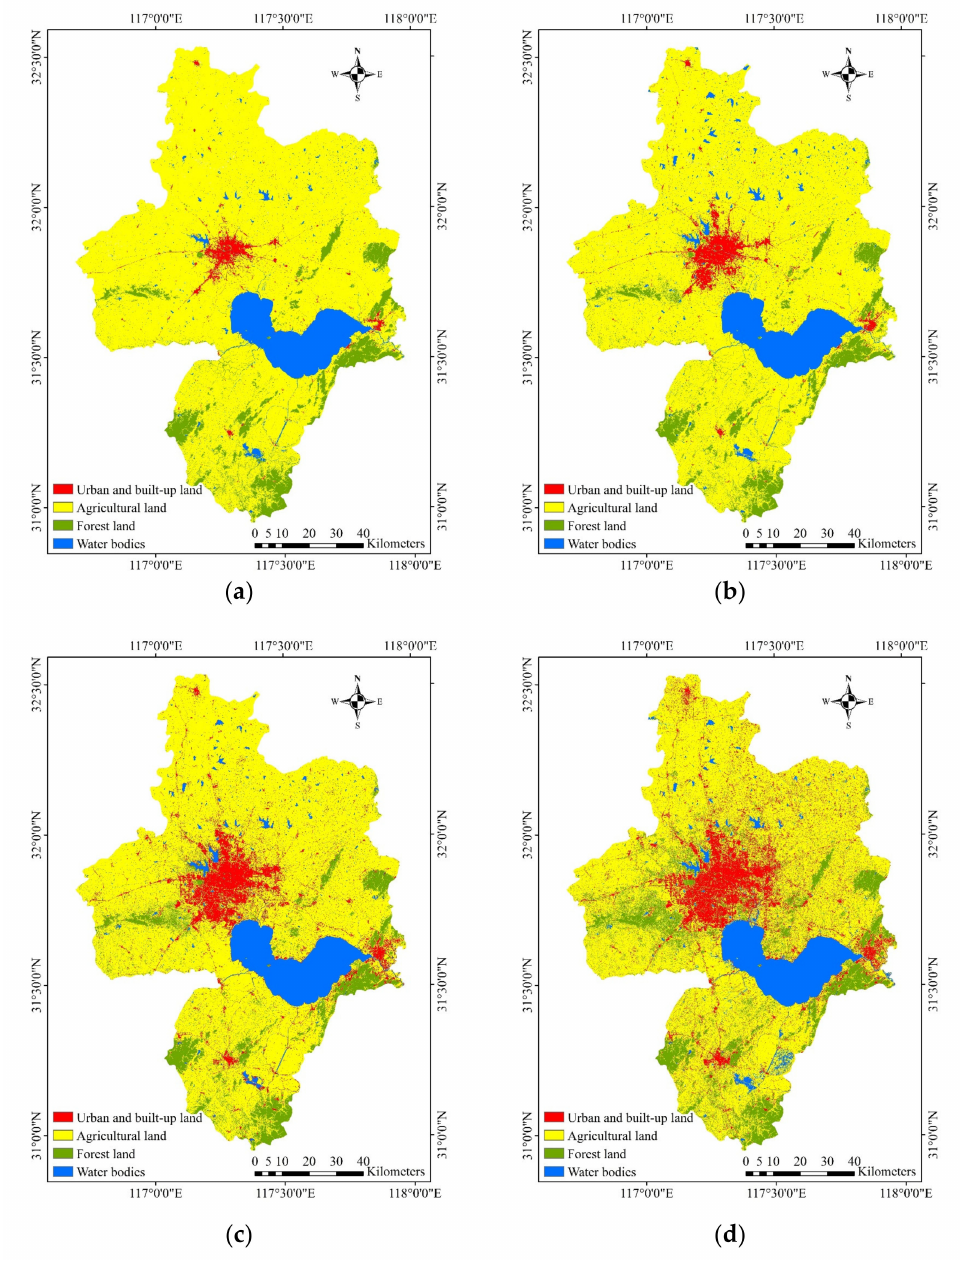
Figure 8. Spatial distribution of classified LULC map in: ( a ) 24 July 2001; ( b ) 28 June 2006; ( c ) 5 August 2014; and ( d ) 5 August